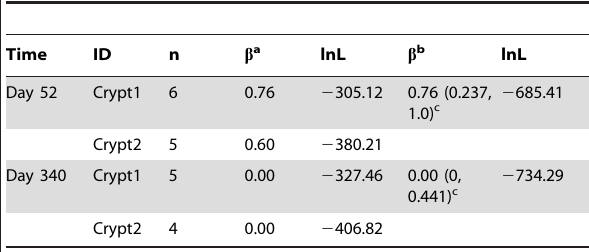
a : estimated for each crypt. b : estimated for each mice. c : confidence interval calculated from the non-parametric bootstrap samples.